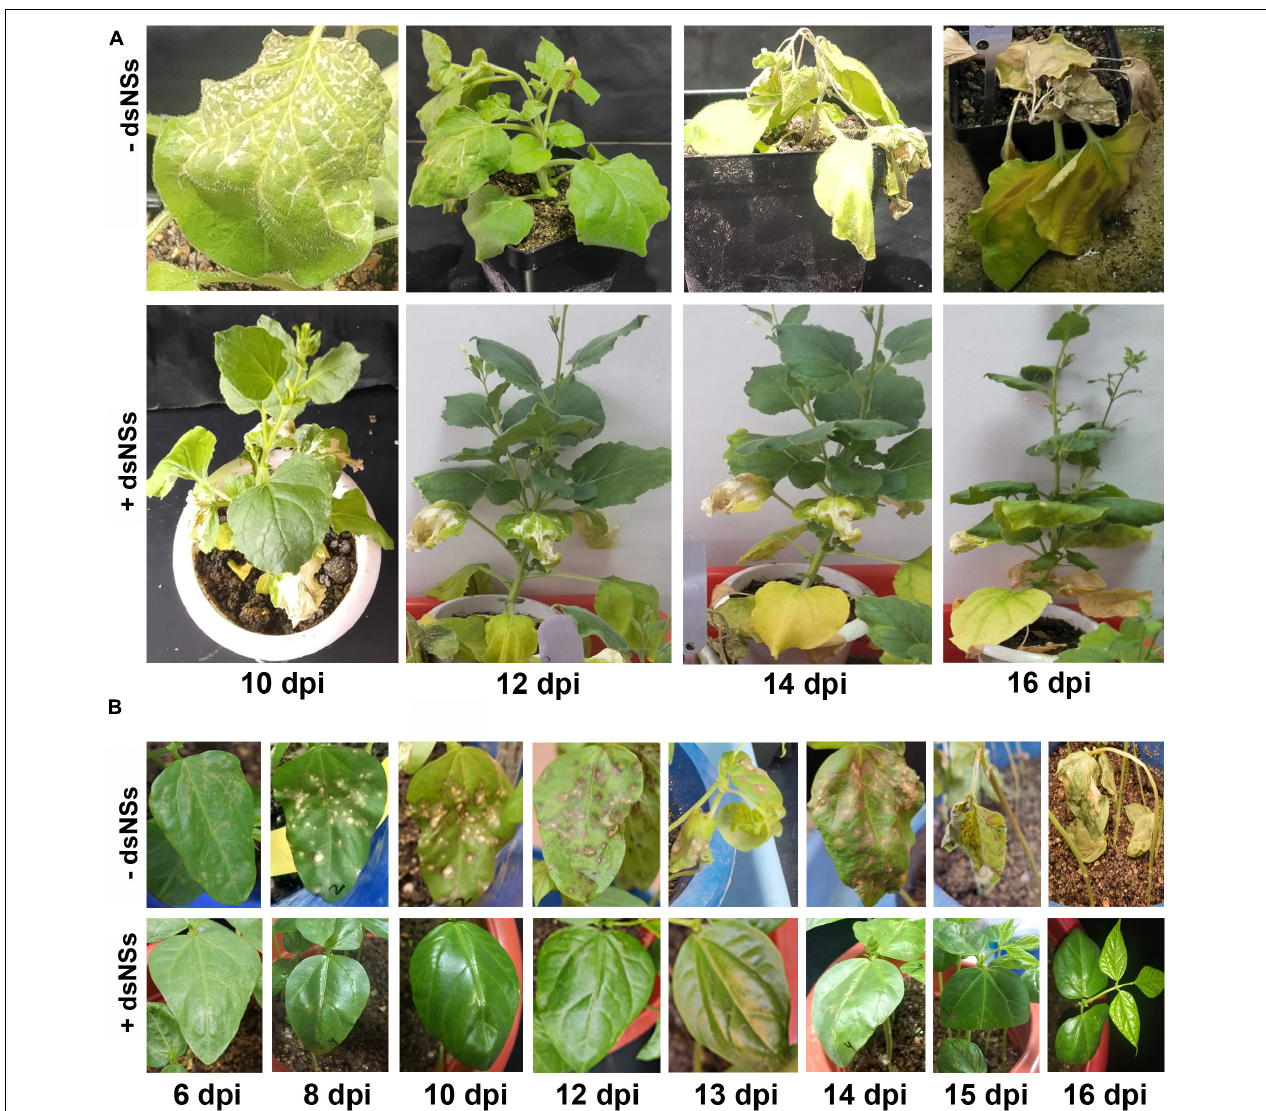
FIGURE 4 | The disease progress of GBNV in Nicotiana benthamiana (A) and cowpea cv. Pusa Komal (B) plants treated with dsNSs. N. benthamiana showed systemic symptoms of GBNV, whereas cowpea showed both local and systemic symptoms. Disease progress was observed at different days post inoculation (dpi) till the death of the inoculated plants. –dsNSs, no dsNSs treatment was given prior to GBNV inoculation; +dsNSs, an amount of 5.0 µ g/plant of dsNSs in autoclaved distilled water containing 0.01% Celite was applied followed by GBNV inoculation after 10–15 min (T2 treatment